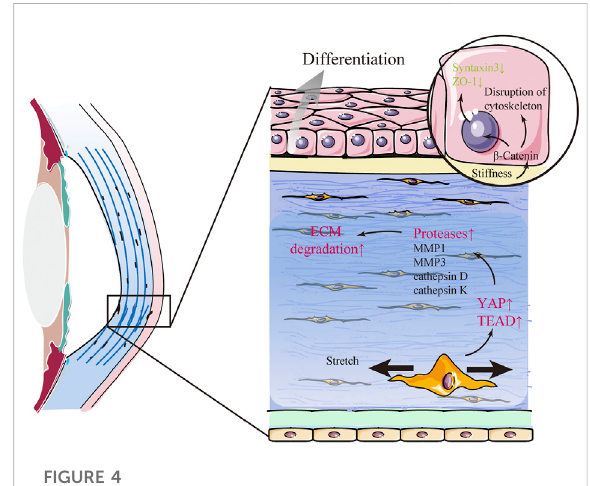
FIGURE 4 Keratoconus(KC)isrelatedtochangesinmechanicalcues.In KC, β -catenin in corneal epithelial cells acts as a mechano- transducer of substrate stiffness that induces abnormal differentiation and structural changes in the corneal epithelium by delocalizing from the membrane to the cytosol. Furthermore, mechanical stretch promotes the expression of several proteases and aggravates extracellular matrix (ECM) degradation via YAP and its cooperator, TEA domain transcription factor (TEAD), in stromal